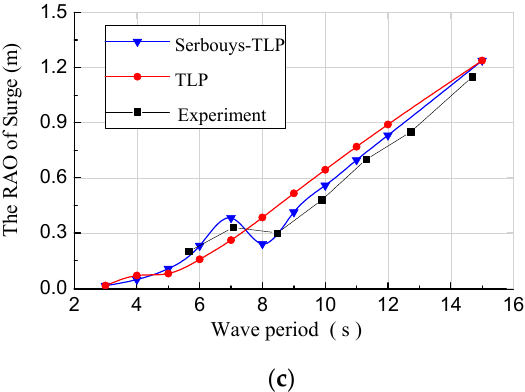
Figure 7. Surge contrast of TLP and Serbuoys-TLP under working condition A, B and C. ( a ) Condition A; ( b ) Condition B; ( c ) Condition C.